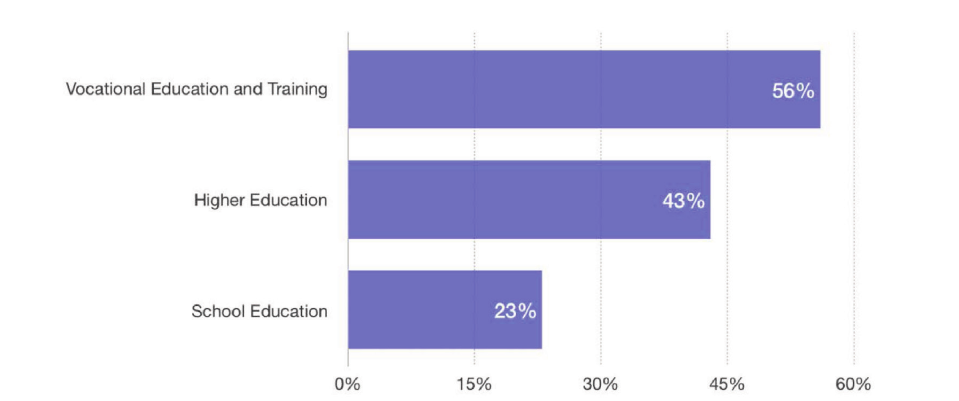
Figure 1: Percentage of teaching-related BLE participants by sector Engagement